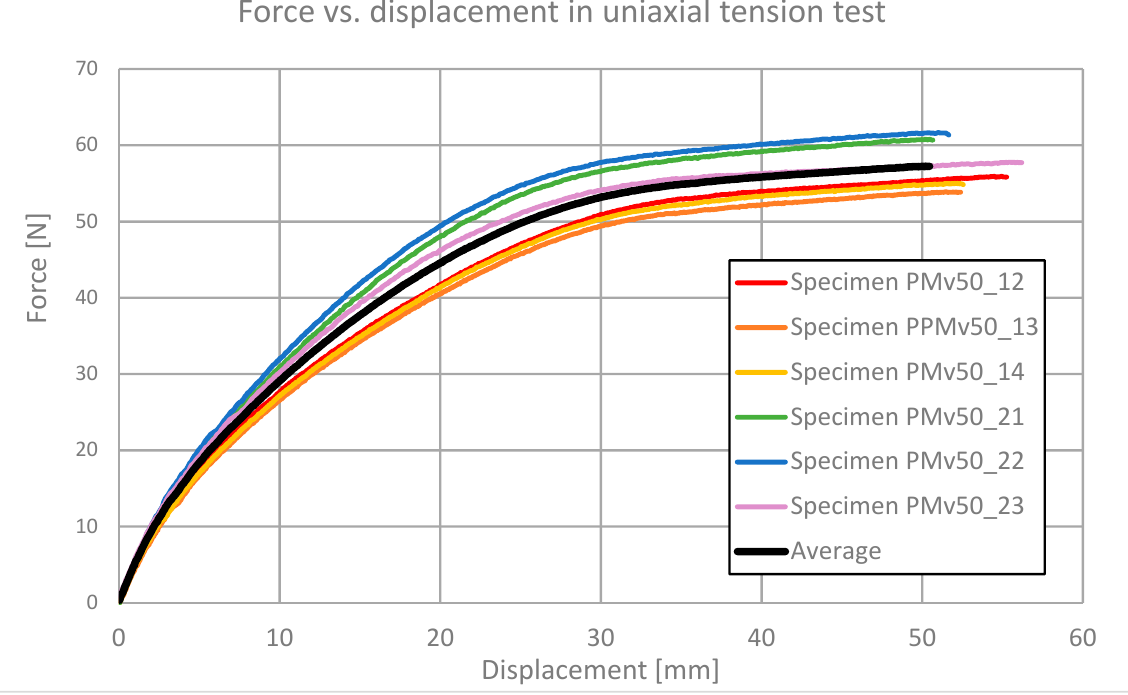
Figure 4. The force–displacement curve for six dogbone specimens in uniaxial tension tests, and an average curve.